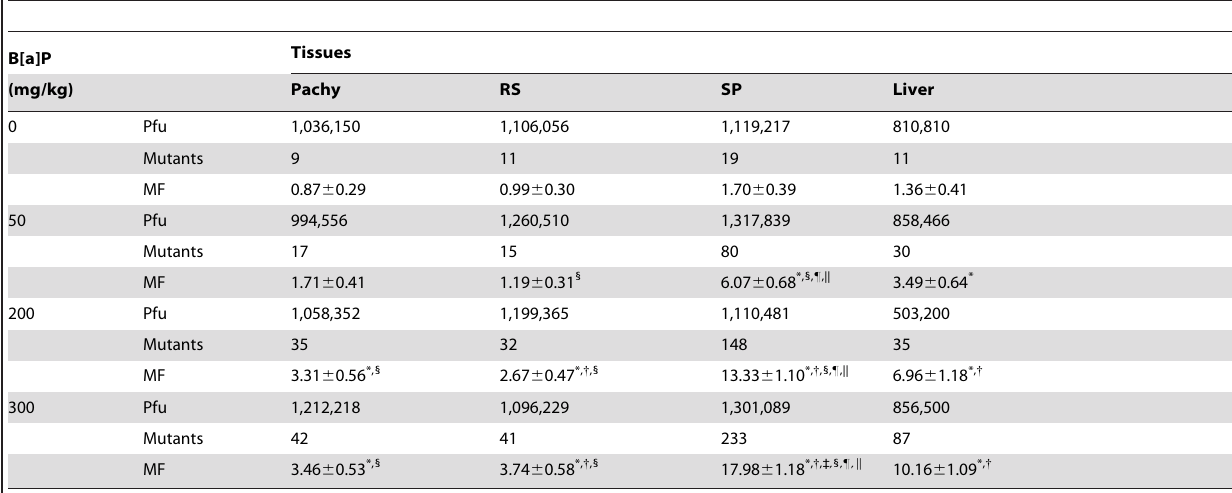
Pfu, plaque-forming unit; MF, mutant frequency; Pachy, pachytene spermatocytes; RS, round spermatids; SP, epididymal spermatozoa. *Significantly (P , 0.05) different from 0 mg/kg, same cell type. { Significantly (P , 0.05) different from 50 mg/kg, same cell type. ` Significantly (P , 0.05) different from 200 mg/kg, same cell type. 1 Significantly (P , 0.05) different from liver, same dose. " Significantly (P , 0.05) different from pachytene spermatocytes, same dose. || Significantly (P , 0.05) different from round spermatids, same dose. doi:10.1371/journal.pone.0087439.t001 B[a]P/kg body weight groups, p , 0.05. MFs in liver tissue in the 200 and 300 mg B[a]P/kg body weight groups were significantly elevated compared with the 0 and 50 mg B[a]P/kg body weight groups, p , 0.05.